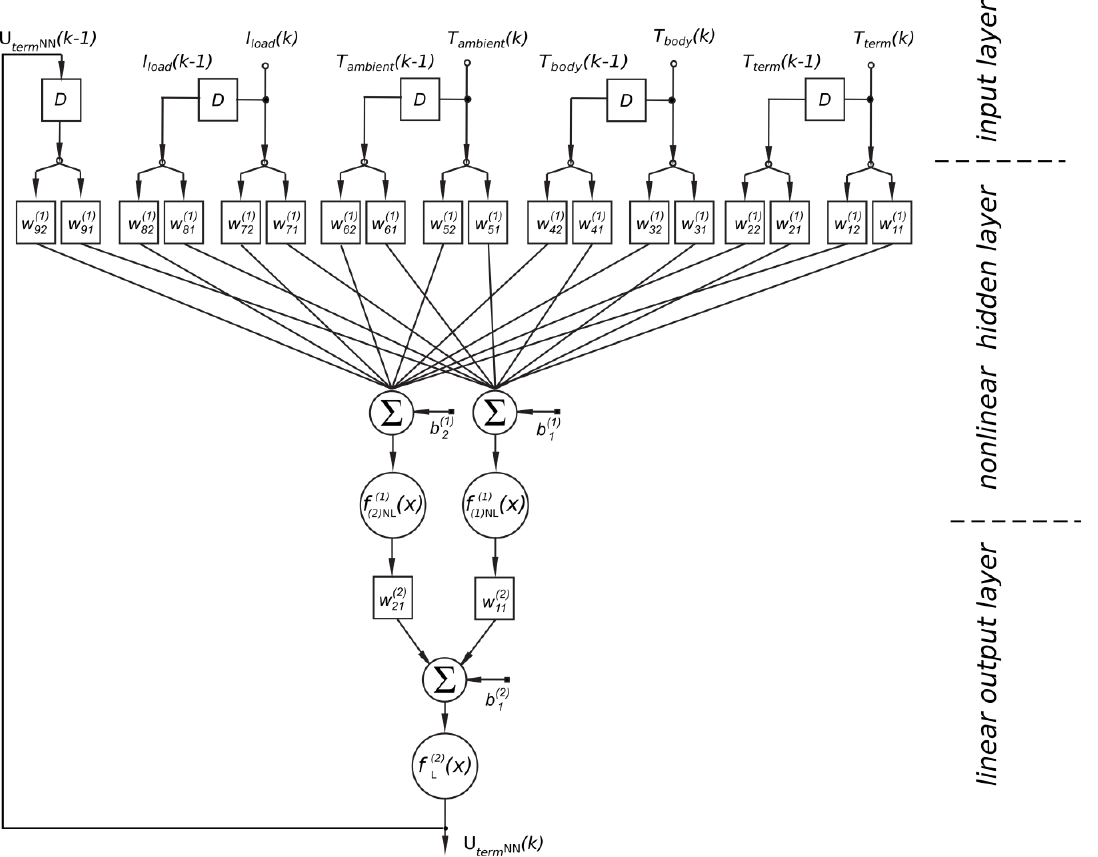
Figure 6. The parallel (recurrent) structure Nonlinear AutoRegressive eXogenous Arificial Neural Network (NARX-ANN) model with two neurons in hidden layer, and one neuron in the output layer (D-Tapped Delay Line).